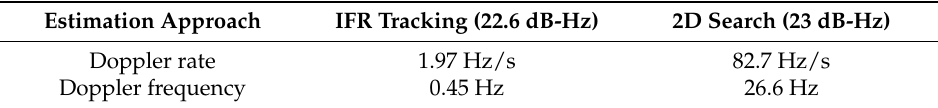
Table 3. Root mean square (RMS) of estimation